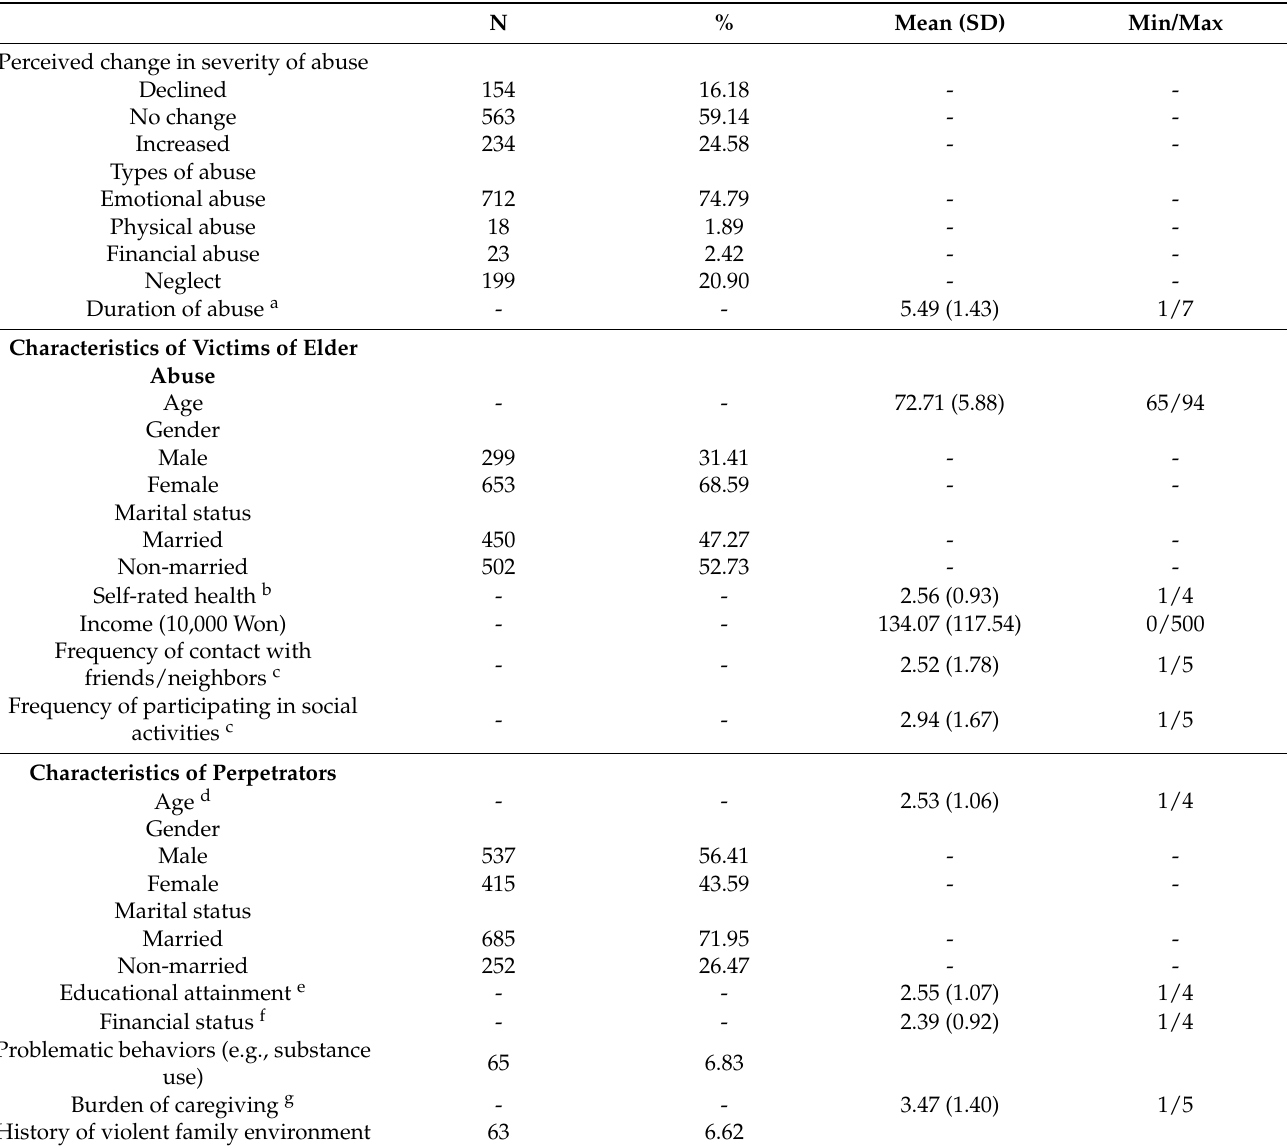
Table 1. Summary statistics of study sample and key variables (N =